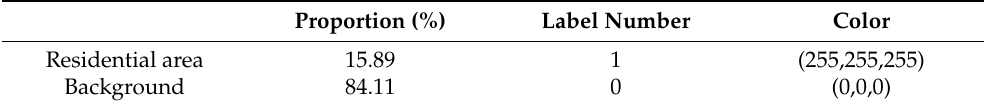
Table 2. The proportion of residential area in our